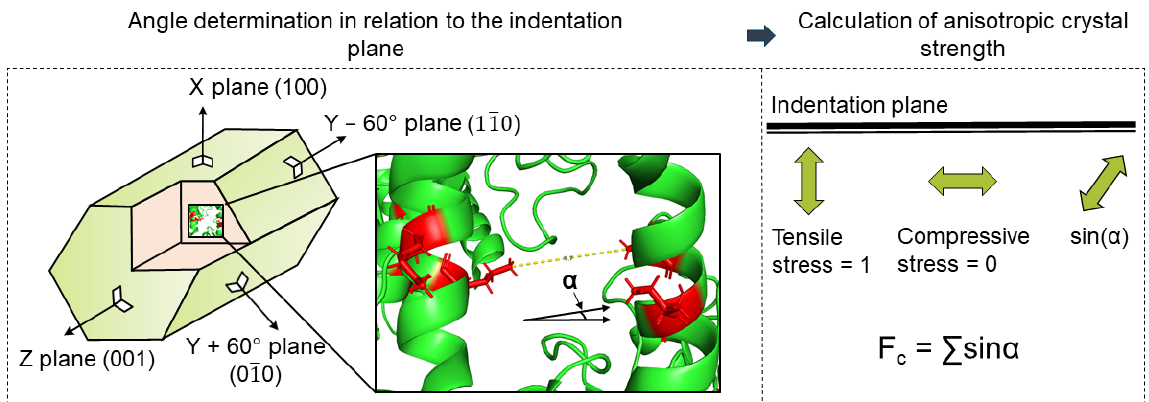
Figure 3. Overview approach to modeling mechanical crystal behavior based on crystal structure: calculation of anisotropic crystal strength using a direction of cross-linking bonds in relation to the indentation plane.